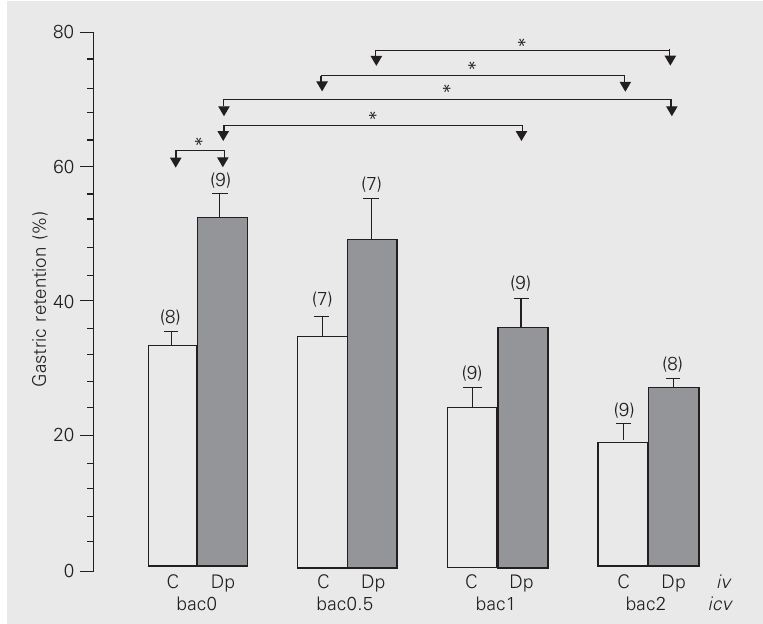
Figure 1. Gastric retention of a saline test meal 10 min after orogastric administration to rats. Eight days before the experiment, all animals were implanted with a stainless steel cannula into the right lateral ventricle. The animals were injected iv with vehicle (C) or 80 mg/kg (240 µmol/kg) dipyrone (Dp), followed by icv injection through an internal cannula of 10 µl vehicle (bac0) or an equal volume of solution containing 0.5, 1 or 2 µg baclofen (bac0.5, bac1 and bac2, respectively). Gastric retention, reported as mean ± SEM in percent, was determined 10 min after removal of the internal cannula. The number of animals in each group is given in parentheses. *P < 0.05